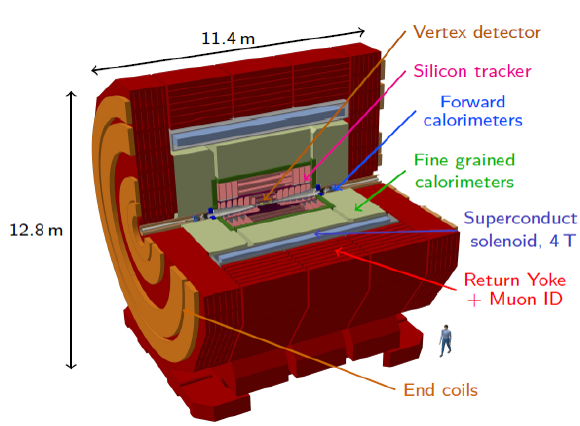
Figure 4. The layout of the CLICdp